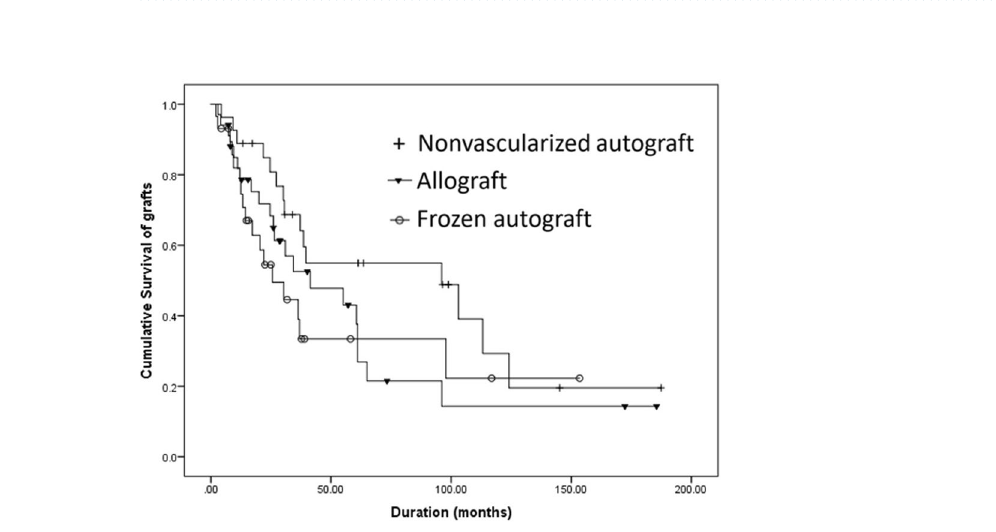
Table 2. Oncologic and functional outcomes.